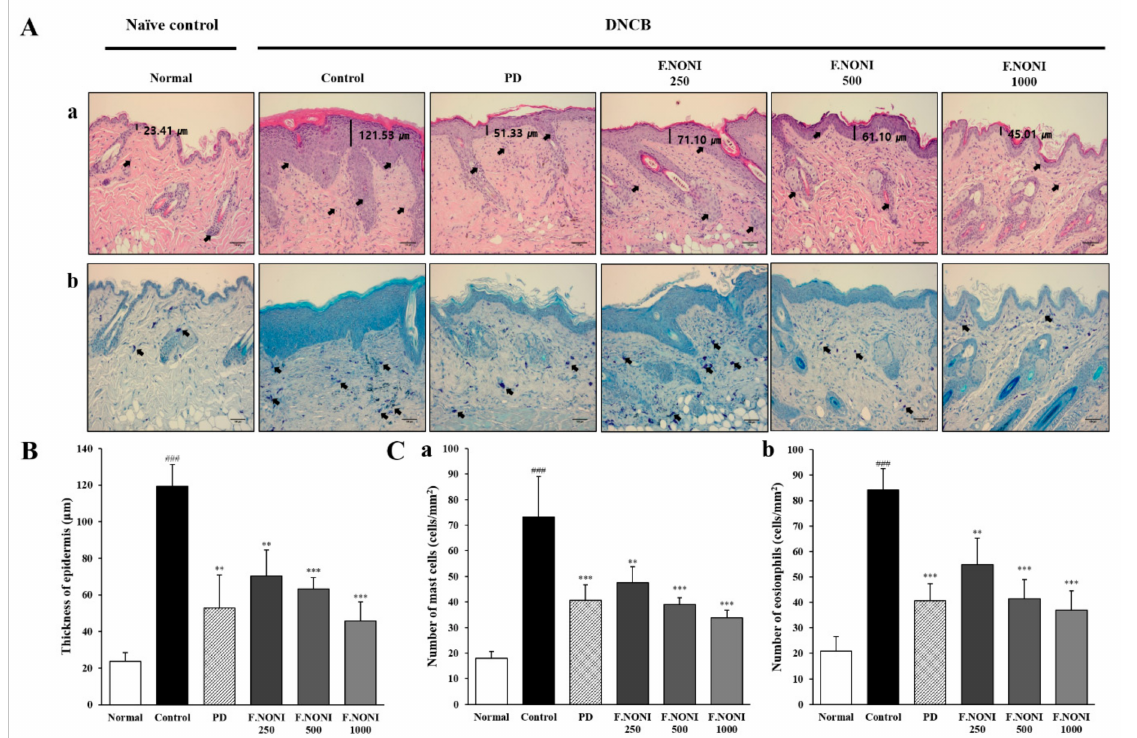
Figure 3. E ff ect of F.NONI on DNCB-induced histological features of AD-like skin lesions in NC / Nga mice. ( A ) Representative dorsal skin images of histological examination (400x, scale bar = 100 µ m); ( a ) H&E staining; the thicknesses of the epidermis are marked with bars, and infiltration of eosinophils is indicated by arrows; ( b ) toluidine blue staining; the infiltrations of mast cells are indicated by arrows. ( B ) The thicknesses of the epidermis were measured in the dorsal skin lesion and averaged. ( C ) The number of infiltrated inflammatory cells, ( a ) mast cells and ( b ) eosinophils, were measured in 1 mm 2 of a dorsal skin lesion and averaged ( n = 6). The results were presented as mean ± SEM ( n = 6). ### p < 0.001 vs. normal, ** p < 0.01, *** p < 0.001 vs. control. Normal, untreated group; Control, atopic dermatitis induced by DNCB; PD, positive control (prednisolone 3 mg / kg) treated group; F.NONI (fermented Morinda citrifolia 250, 500, or 1000 mg / kg) treated